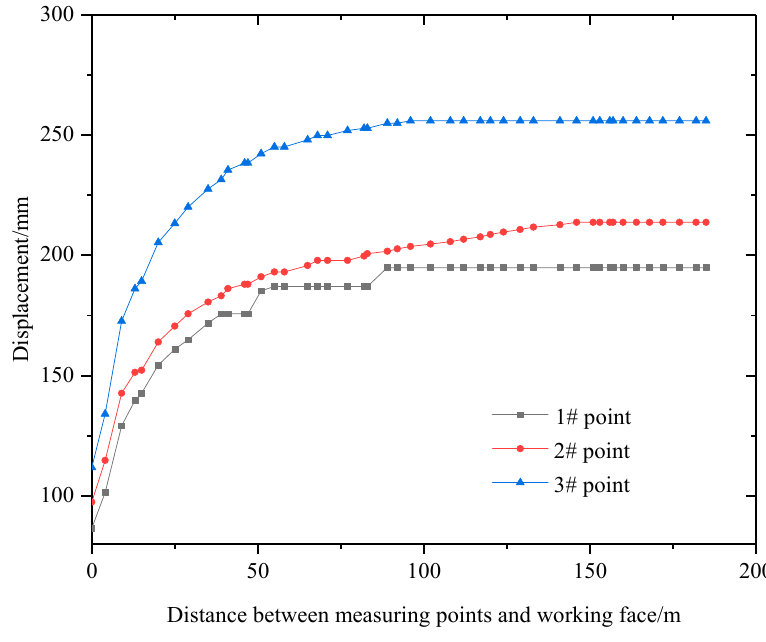
Figure 16. Roof subsidence of the gob.